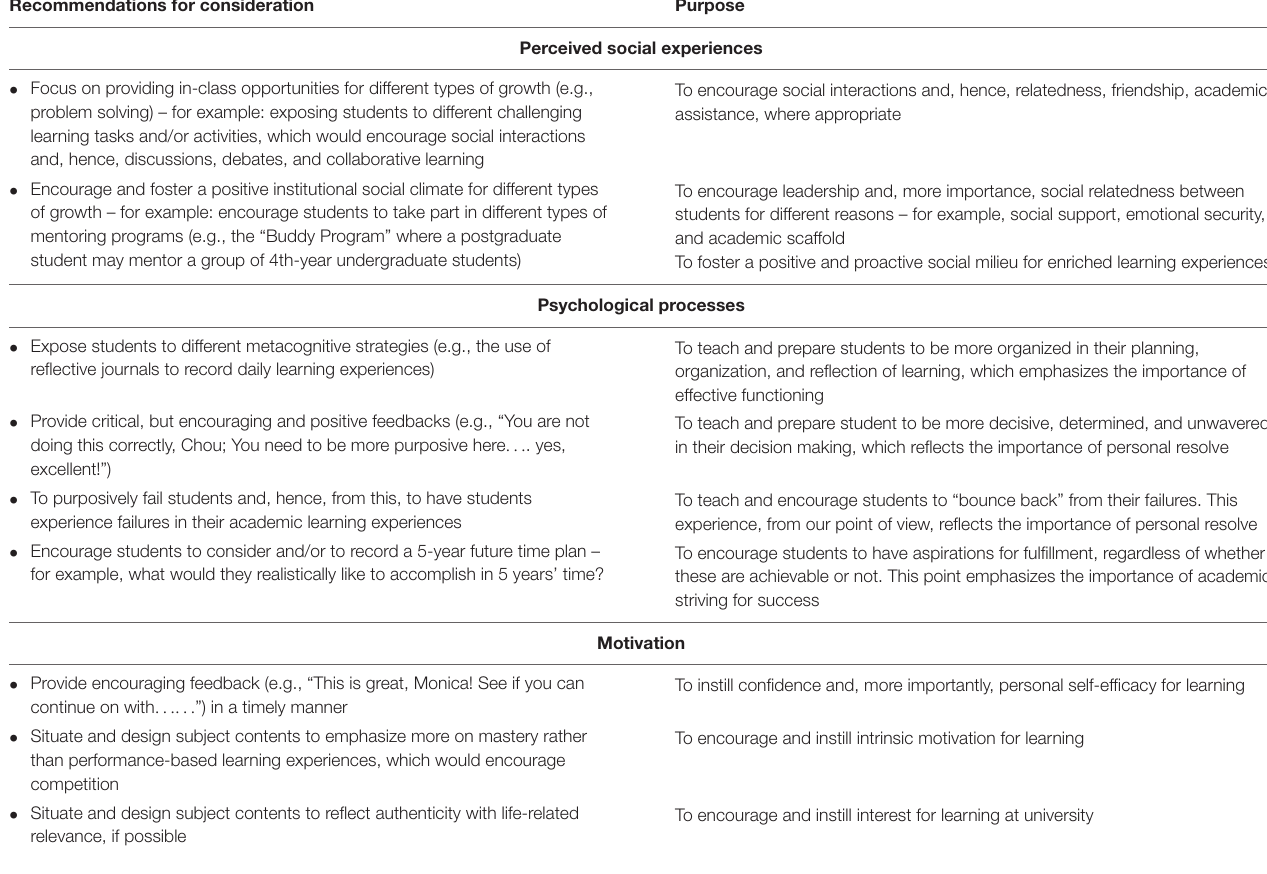
TABLE 6 | A summary of educational